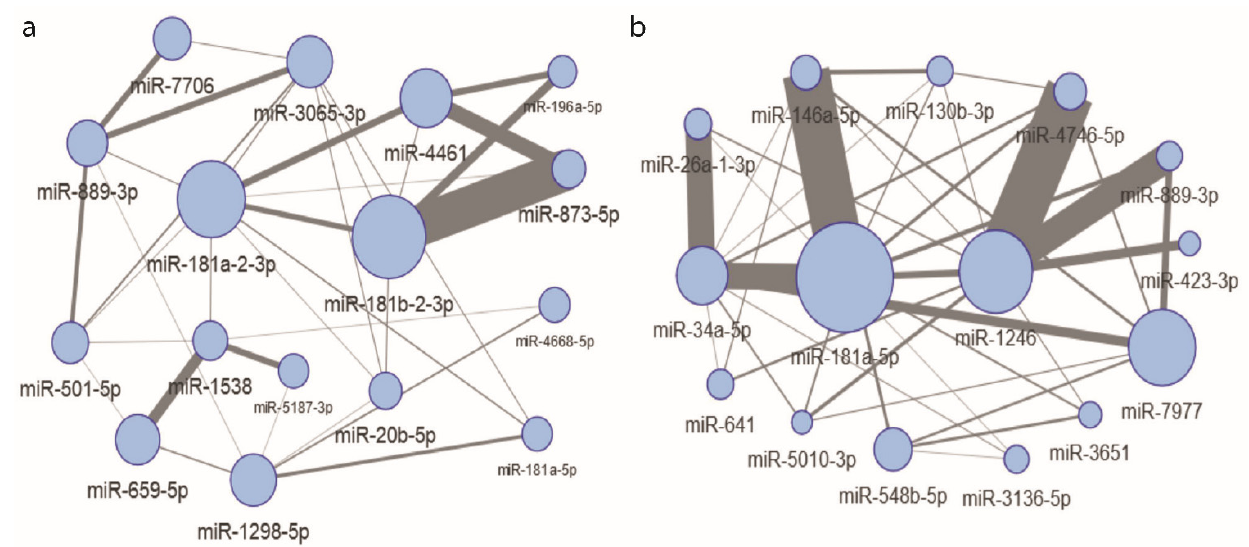
Figure 4. Graphs presenting dose informative interactions between miRNAs represented as circles for comparison of 0 Gy to other doses ( a ) and comparison of subsequent doses ( b ) using the Broadside algorithm. The diameter of a miRNA symbol represents the main effect (impact of the single miRNA on dose prediction), while the width of the line between miRNAs represents the strength of an interaction effect (impact of the pair of miRNAs on dose prediction).